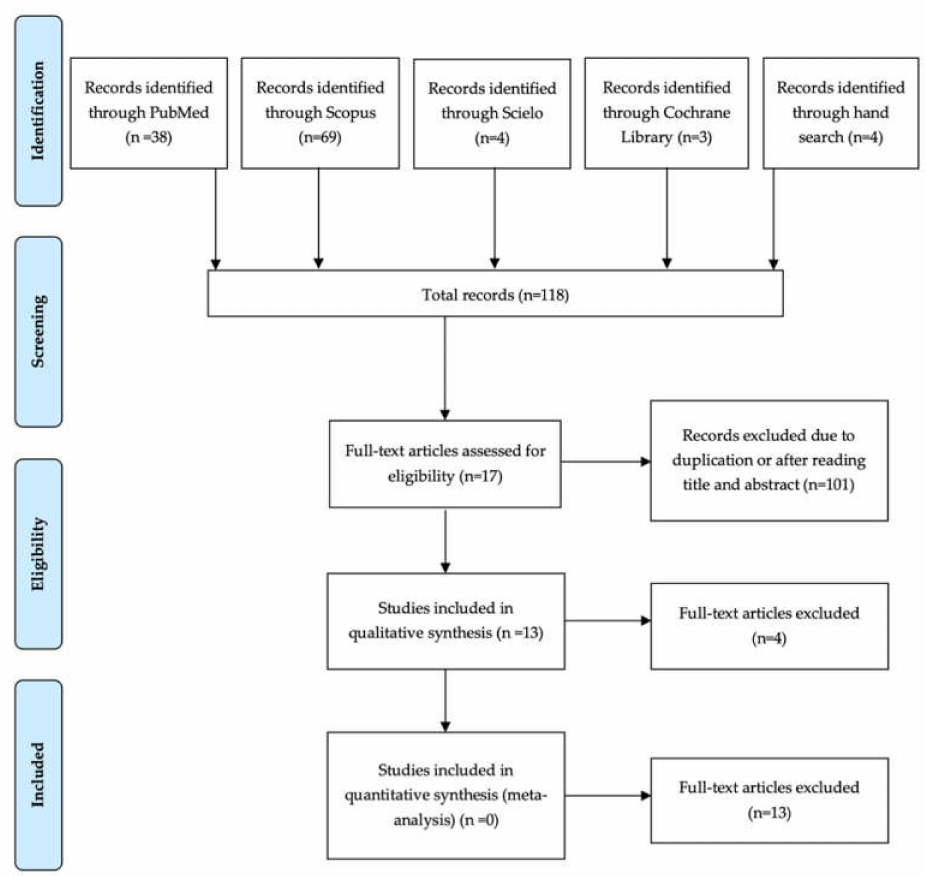
Figure 2. Preferred Reporting Items of Systematic Reviews and Meta-Analyses (PRISMA) flow diagram of selection